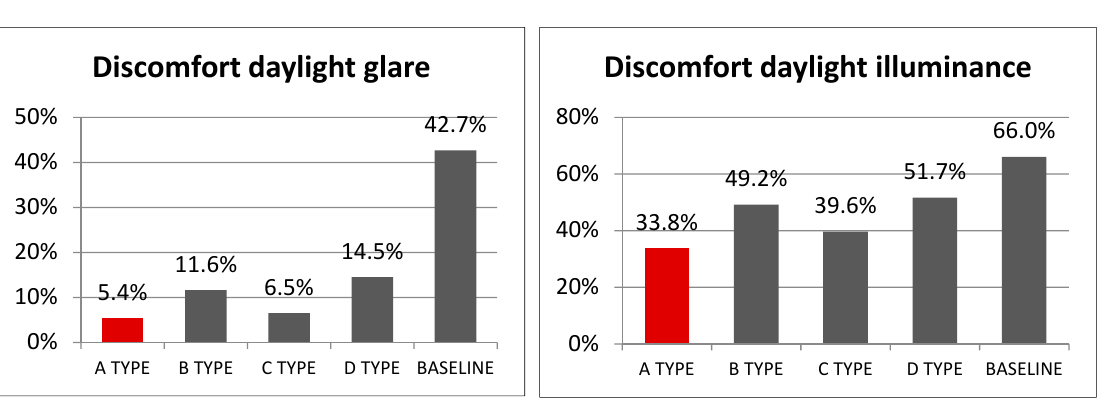
Figure 14. Annual time ratio of 22 or higher DGI (left) and annual time ratio of discomfort daylight illuminance (right).